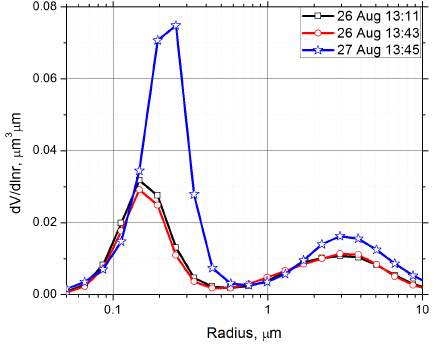
Figure 15. Column integrated particle size distributions provided by AERONET on 26 and 27 August.